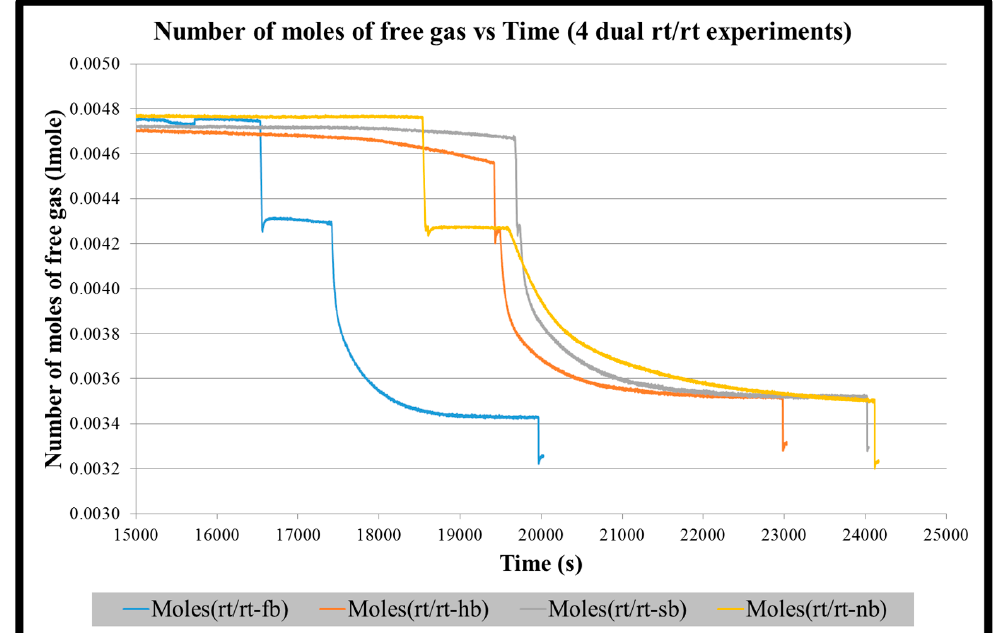
Figure A3. Number of moles of free gas vs. time for four dual pbt / pbt impeller experiments until the Energies 2020 , 13 , x FOR PEER REVIEW 15 of 16 Figure A3 Number of moles of free gas vs. time for four dual pbt/pbt impeller experiments until the start of stabilization of hydrate formation. start of stabilization of hydrate formation .